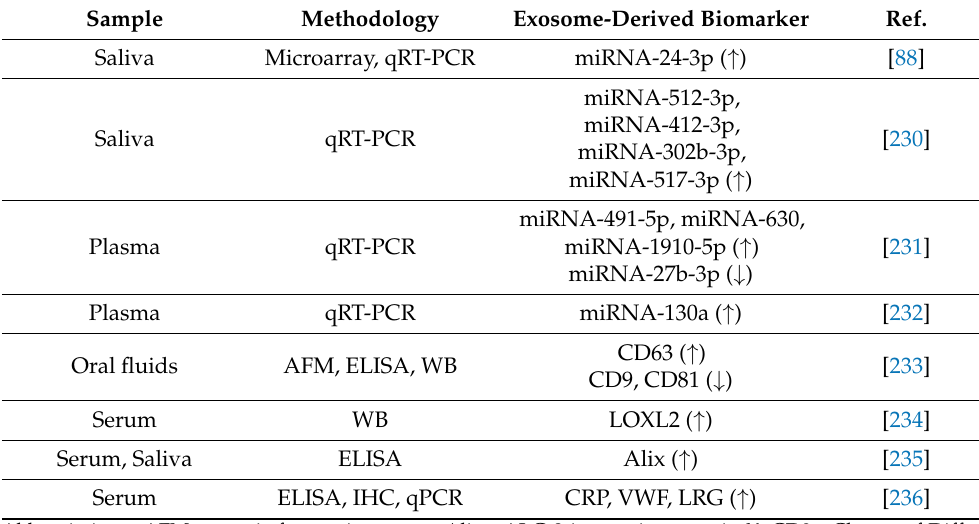
Table 2. The exosome-derived biomarkers for oral cancer diagnosis. Sample Methodology Exosome-Derived Biomarker Ref. Saliva Microarray, qRT-PCR miRNA-24-3p ( ↑ )